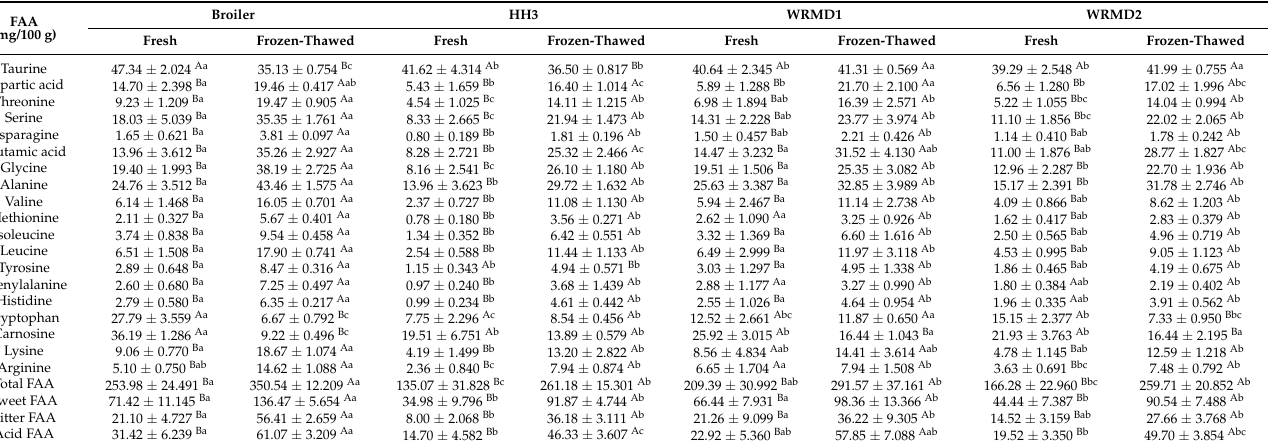
Table 4. Comparison of free amino acids (FAA) in fresh and Frozen-Thawed chicken thigh meat from Korean native chickens and